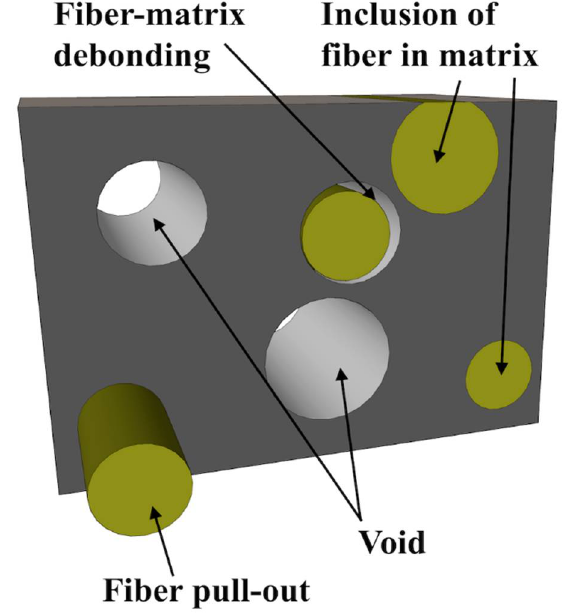
Figure 1. Analysis of fractured surface in composites reinforced with fibers (redrawn from Ref. [39]).